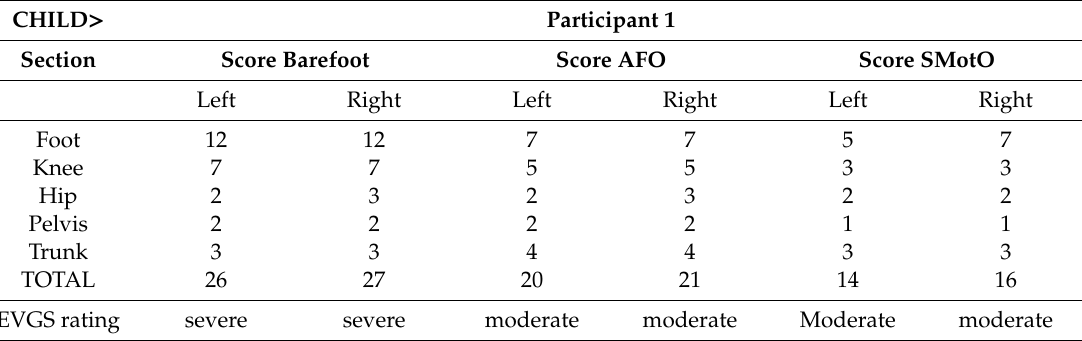
Table A1. Participants with three scores (participant